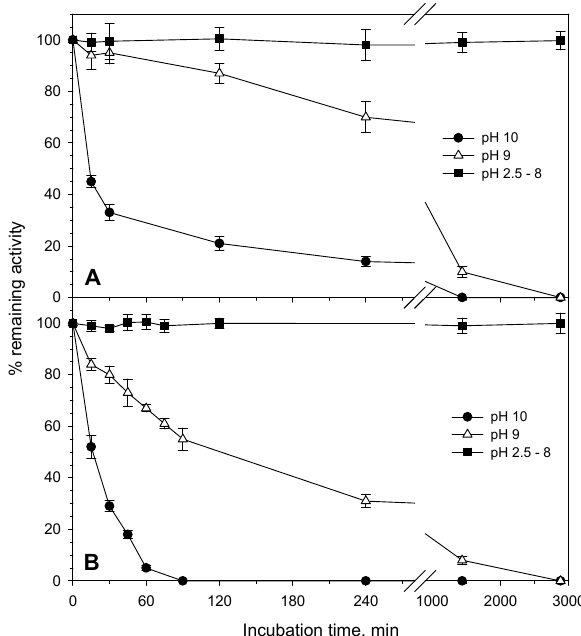
Figure 4. pH stability analysis for the purified PvXyn11A ( A ) and PvXyd3A ( B ) of B. spectabilis ATHUM 8891 at 40 °C.